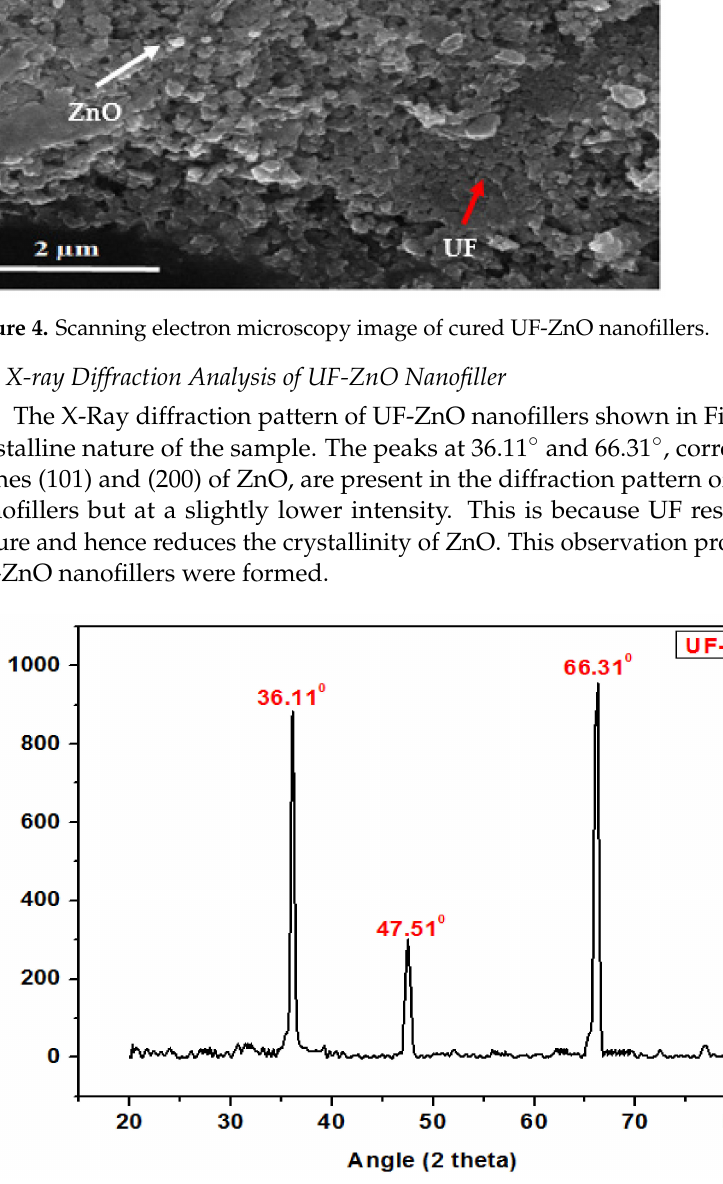
Figure 5. X-ray diffraction analysis of UF-ZnO